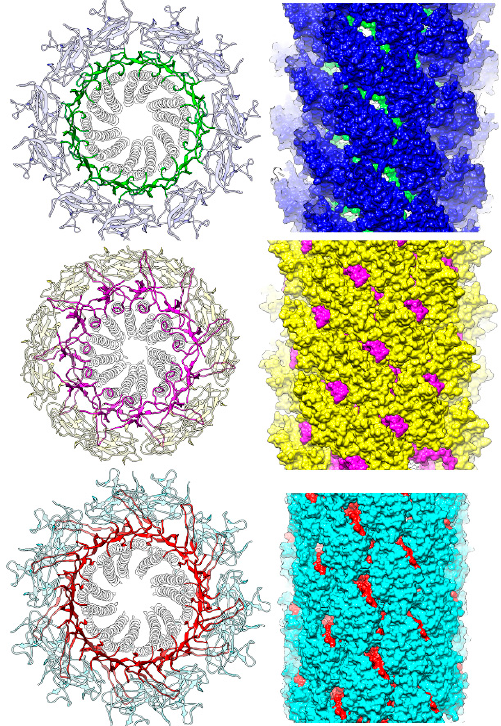
Figure 7. Structural comparison of Salmonella hook and rod and Campylobacter hook. The C α ribbon models of Salmonella hook at the top, the rod in the middle, and Campylobacter hook at the bottom. The models are presented in the end-on and side views in the left and right panels, respectively, with only D0-Dc and D1 domains being shown for both hook structures. The Dc domains are highlighted in the left panels by different colors, and the D1 domains are also colored in the right panels. The gaps between the D1 domains are clear in the Salmonella hook structure at the top right, but the gaps are filled by the tip of the β -hairpin of domain Dc in the Salmonella rod and Campylobacter hook structures, further stabilizing and rigidifying their tubular structures.